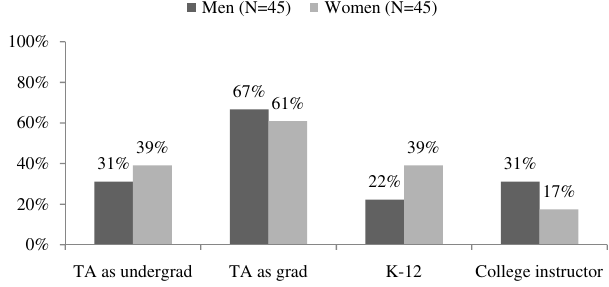
FIG. 2. Setting of physics classes graduate students have taught.